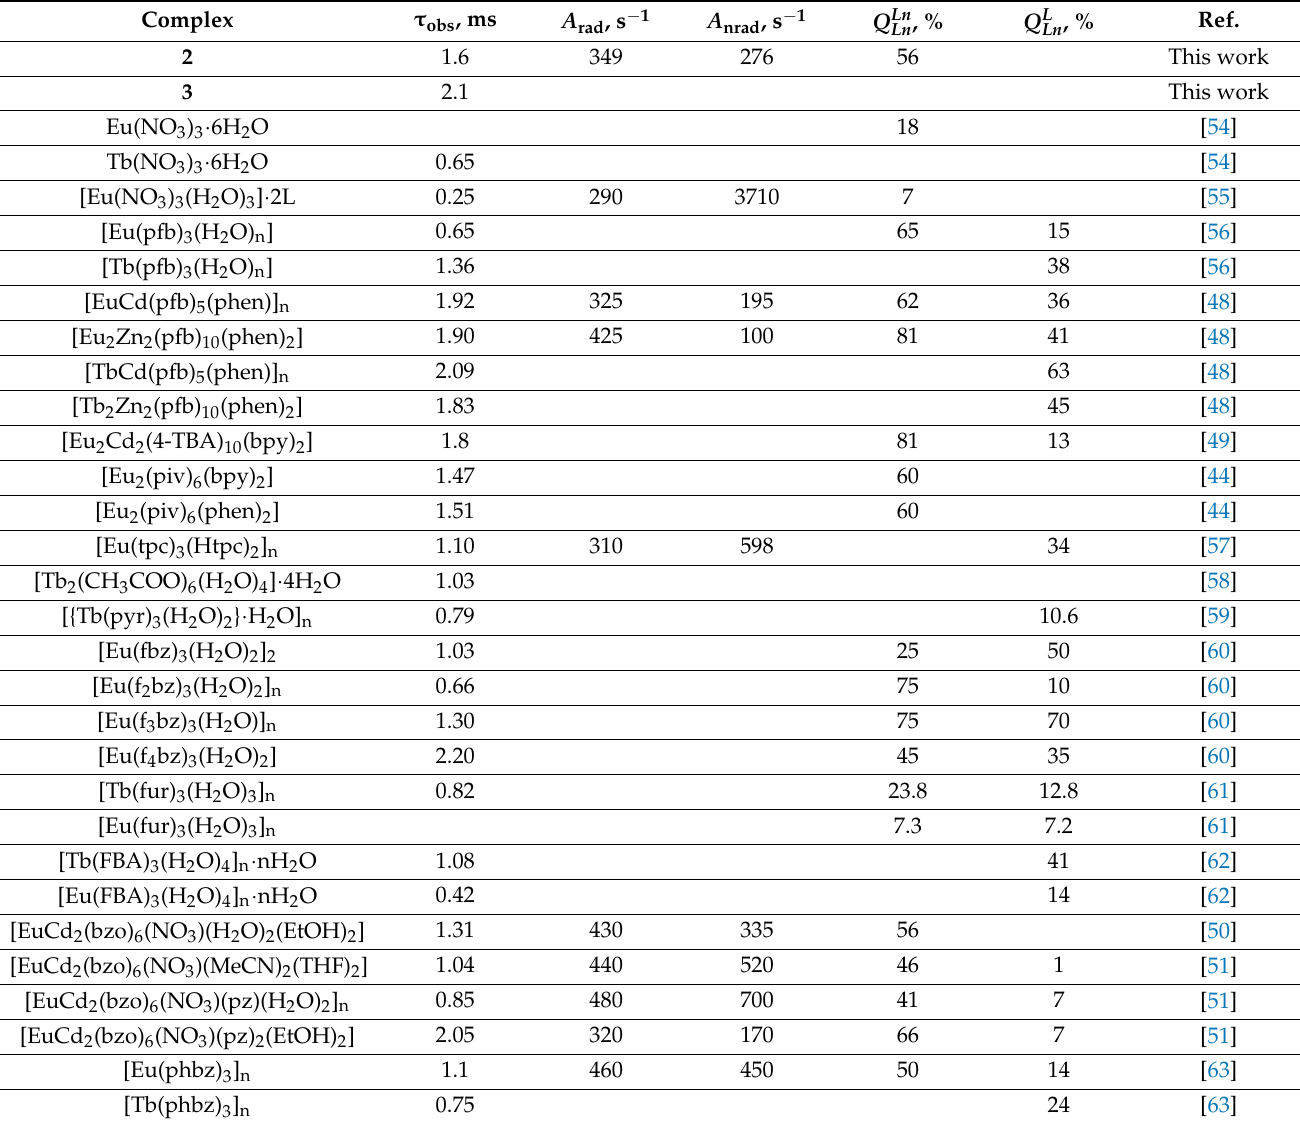
Table 2. Lifetimes ( τ obs ), rate constants of radiative ( A rad ) and non-radiative ( A nrad ) decay, intrinsic ( Q Ln quantum